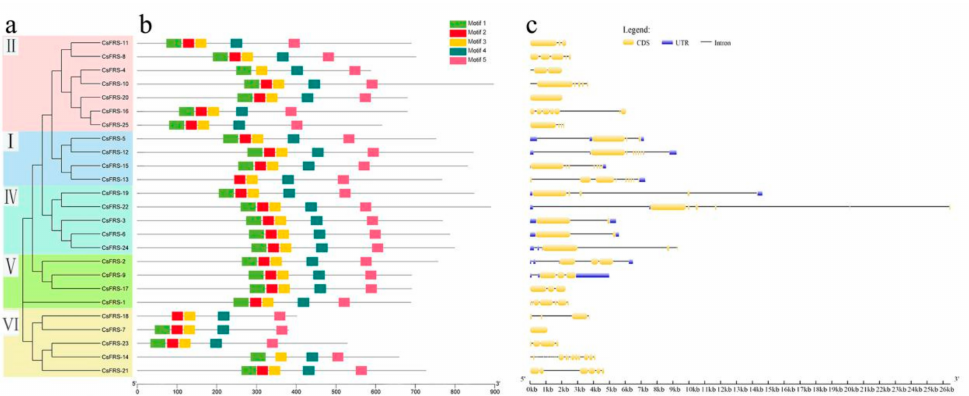
Figure 2. Comparative gene structure and motif analysis of CsFHY3/FAR1s. ( a ) Phylogenetic analysis and classification of CsFHY3/FAR1s. The subtree branch lines are colored in order to indicate the different subfamilies. ( b ) Motif analysis of CsFHY3/FAR1s. The top five motifs identified from the tea plant proteins obtained by the MEME analysis. ( c ) Exon-intron structures of CsFHY3/FAR1s . The exons are marked as yellow boxes, and the introns are represented by black lines; UTRs are shown as blue